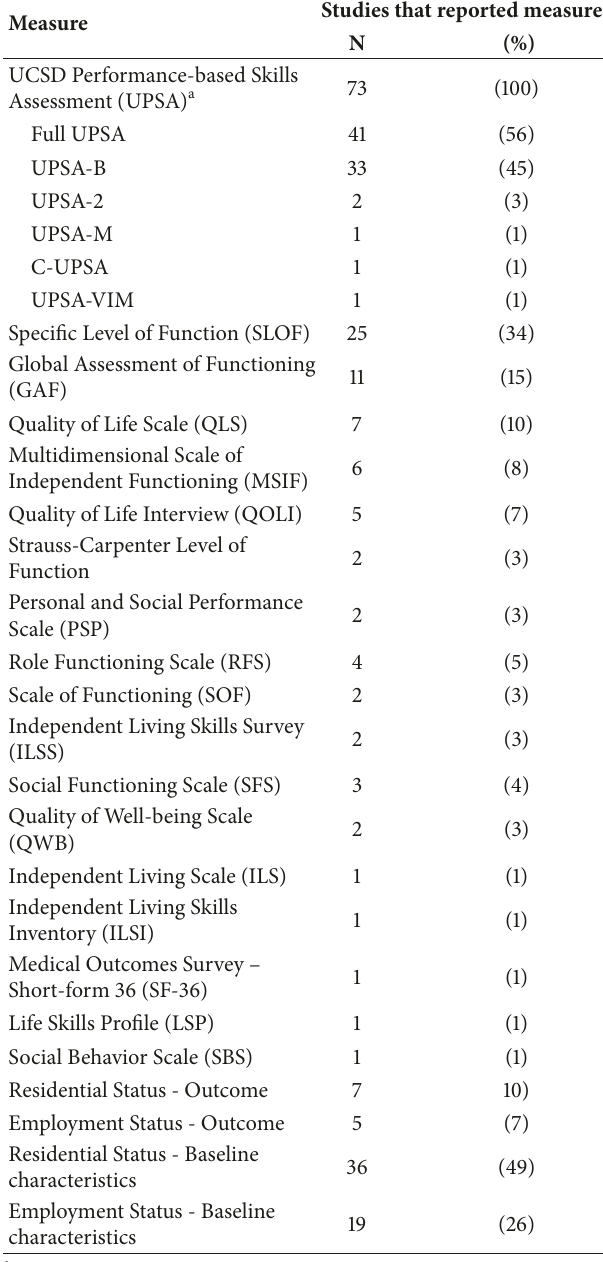
Table 1: Availability of measures in the identified